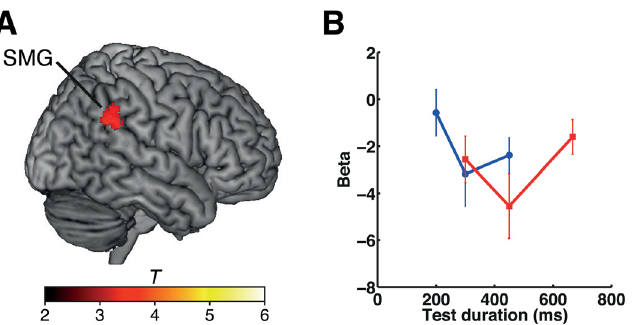
Fig 8. Duration adaptation effects in experiment 4. (A) The cluster showing a duration adaptation effect is shown on a standard brain. (B) Plots of the beta values under each set of stimulus conditions in the 300-ms (blue) and the 450-ms (red) reference blocks at the peak coordinates of the cluster in the right SMG ( x , y , z = 54, − 42, 28). Please refer to S1 Data for the numerical values underlying this figure. The color scale indicates the T -values. Error bars indicate standard errors of the mean.